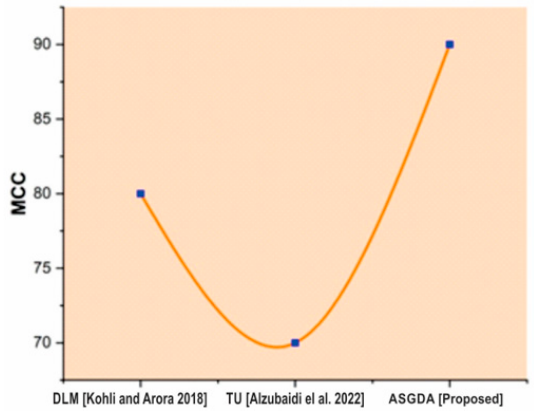
Figure 7. Comparison of MCC of existing and proposed method [40,41].